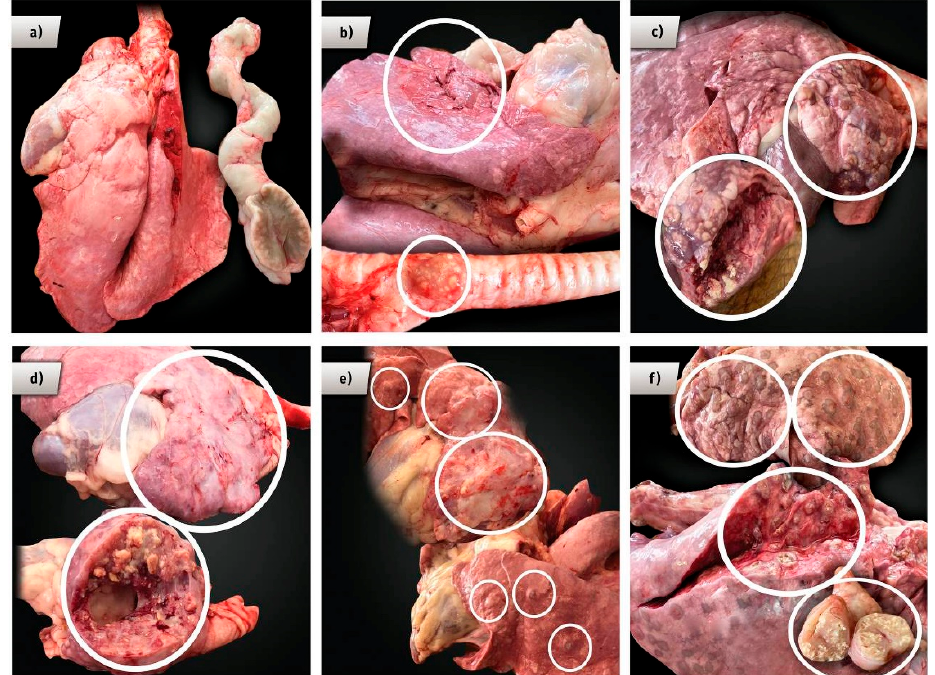
Figure 3. Illustration of the score values in experimental animals vaccinated against tuberculosis (TB) with different vaccine protocols and challenged with a Mycobacterium bovis wild-type strain. ( a ) Score 0, no visible lesions, ( b ) Score 2, small focal purulent tuberculous lesion in the lung’s cranial lobe, ( c ) Score 4, medium-sized purulent tuberculous lesion in the lung’s cranial lobe, ( d ) Score 6, large purulent tuberculous lesion in pulmonary cranial lobe, ( e ) Score 8, multiple small focal tuberculous lesions in lungs, and a medium-size purulent lesion in the cranial lobe, and ( f ) Score 10, multiple small tuberculous lesions covering the lungs and large lesions in the pulmonary cranial lobe and the lymph nodes.